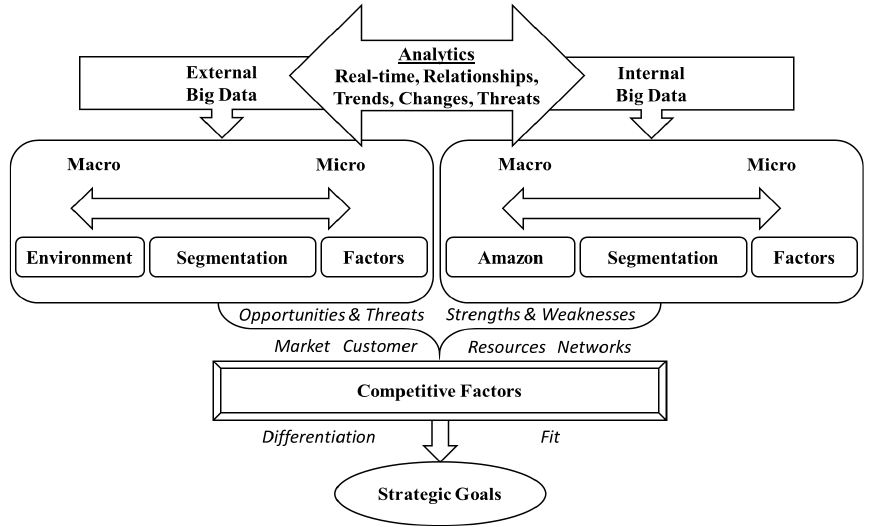
Fig. 8. SWOT and Business Model Applying Big Data